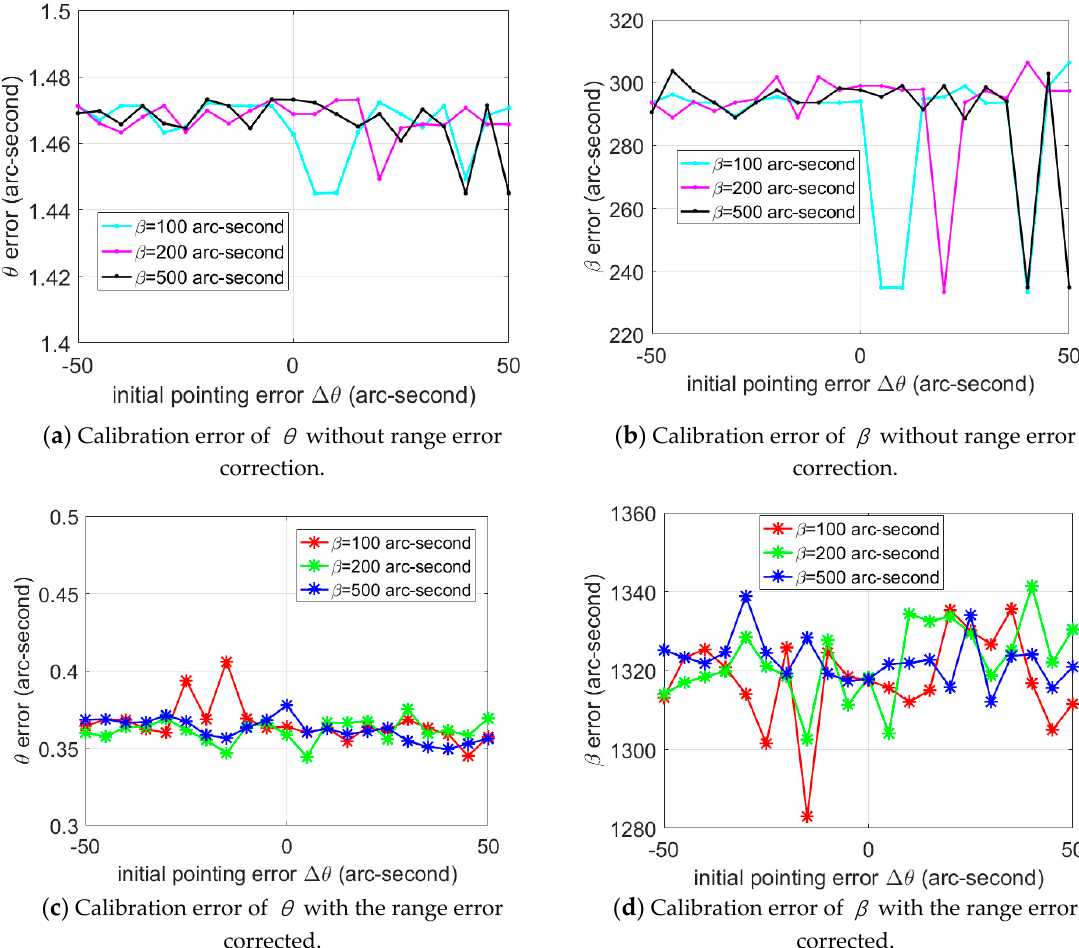
Figure 10. The influence of range error on the calibration results of θ and β . ( a ) and ( b ) show the calibration errors of θ and β without range error correction; ( c ) and ( d ) show the calibration errors of θ and β when the range error is corrected. In addition, 1 km length tracks were